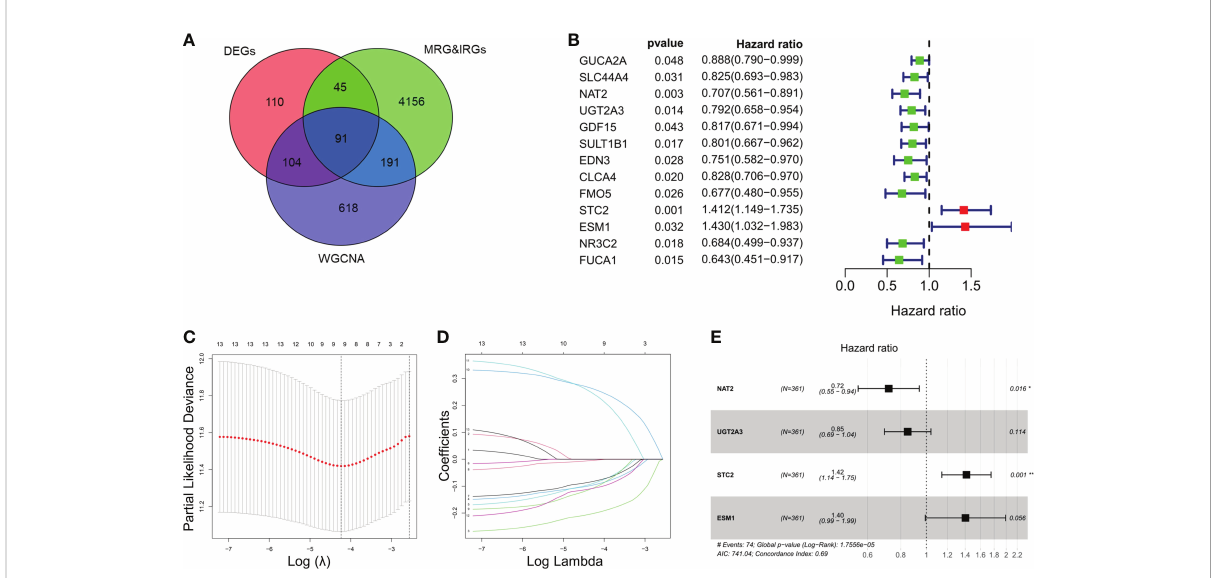
FIGURE 1 Identi fi cation and enrichment analysis of metabolism-related genes (MRGs) and immune-related genes (IRGs). (A) Venn diagram of 91 differentially expressed MRGs and IRGs intersections. (B) Univariate Cox regression analysis of the relationship between in different genes and OS. (C) Cross-validation for tuning parameter selection using LASSO Cox regression. (D) Coef fi cient pro fi les in the LASSO Cox regression model. (E) Forest plots of univariate Cox regression analysis of different gene expression and the corresponding OS. * P < 0.05, ** P <